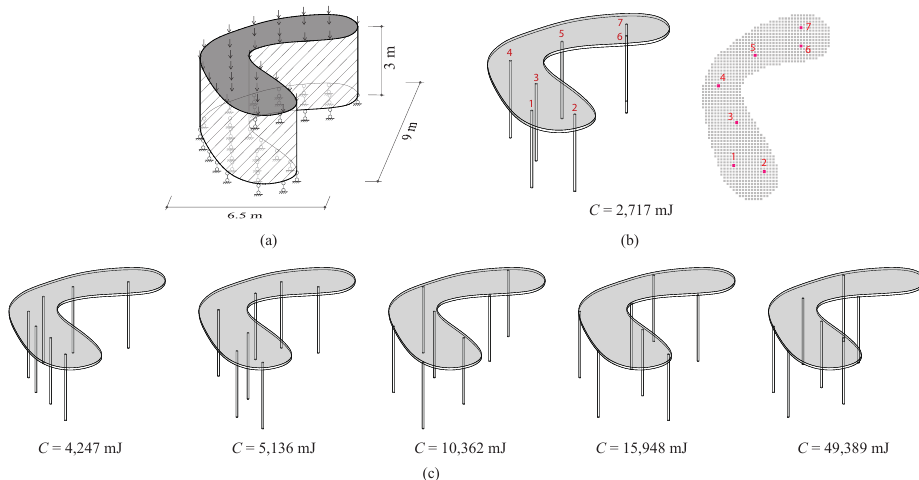
Figure 8. Designing column locations under bean-shaped roof. ( a ) Design domain. ( b ) Optimization result. ( c ) Manual